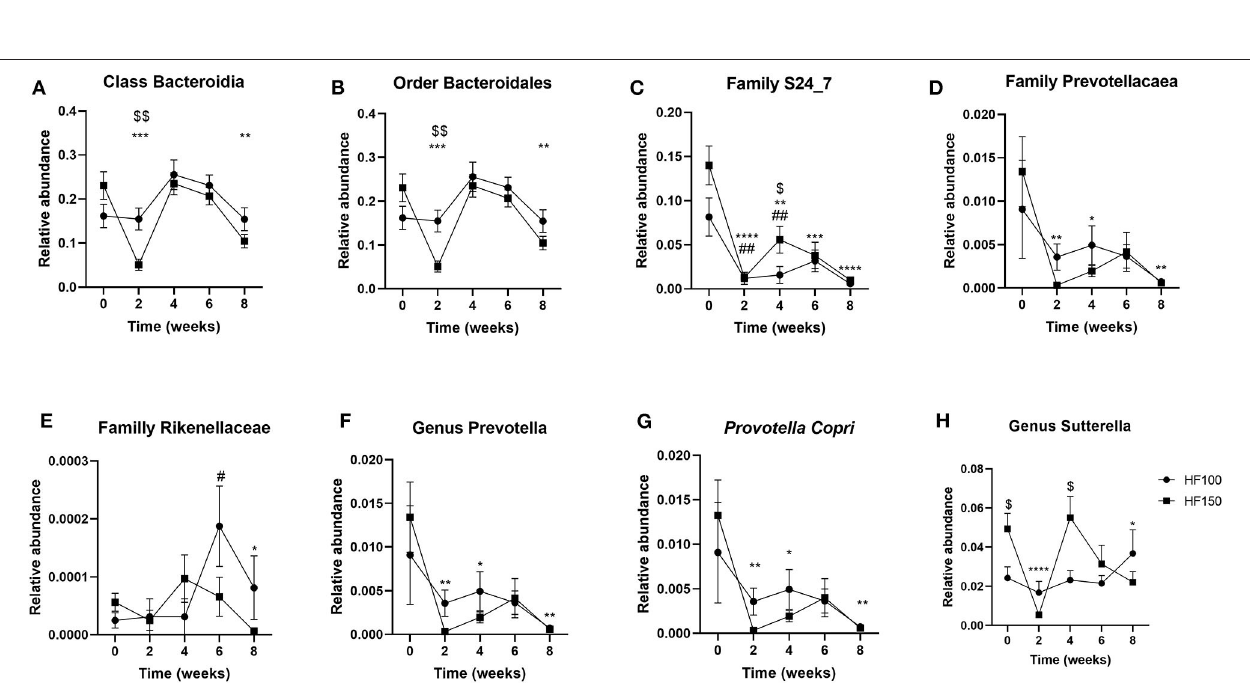
FIGURE 4 | Relative abundance of the fecal bacterial groups belonging to the phyla Firmicutes [ (A) Clostridia, (B) Clostridiales, (C) Clostridiaceae, (D) Lachnospiraceae, (E) Clostridium, and (F) Ruminococcus] and Fusobacteria [ (G) Fusobacteriaceae and (H) Fusobacterium] in dogs fed the high-fat diet at maintenance (HF-100; n = 8) and at 150% maintenance (HF-150; n = 16) for 8 weeks. Data are mean ± SEM. * P < 0.05, ** P < 0.01, *** P < 0.001, **** P < 0.0001 during the HF-150 diet vs. week 0, # P < 0.05 at week 2 vs. week 0 for HF-100 group, $ P < 0.05, $$ P < 0.01 HF-150 vs. HF-100 at weeks 0 and 2.